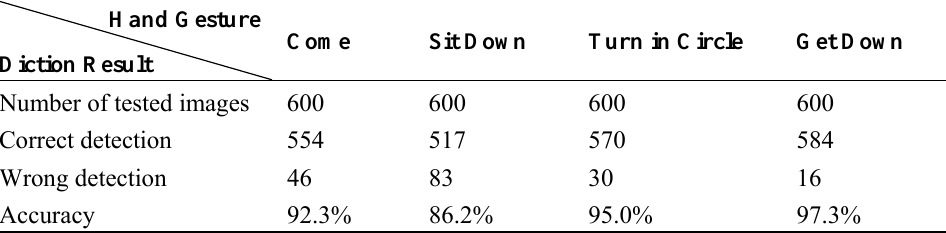
Table 3. Accuracy of dynamic hand gesture.